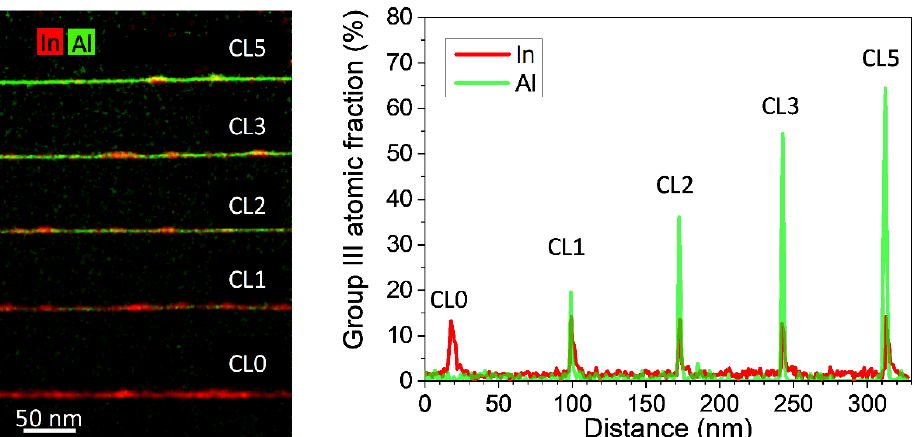
Figure 3. ( left ) Low magnification elemental EDX map for In and Al elements together with ( right ) In and Al atomic fraction profiles along the growth direction. In and Al atomic fraction profiles along the growth